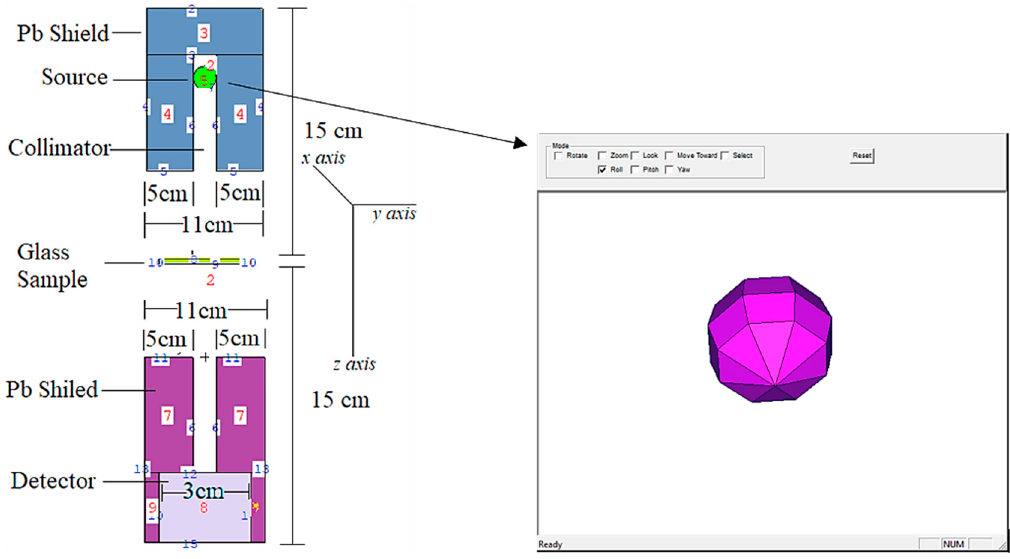
Figure 2. 2-D view and dimensions of designed MCNPX simulation setup for gamma ray transmission competencies of VPB x Cu y glasses (obtained from MCNPX Visual Editor VE VisedX22S) .